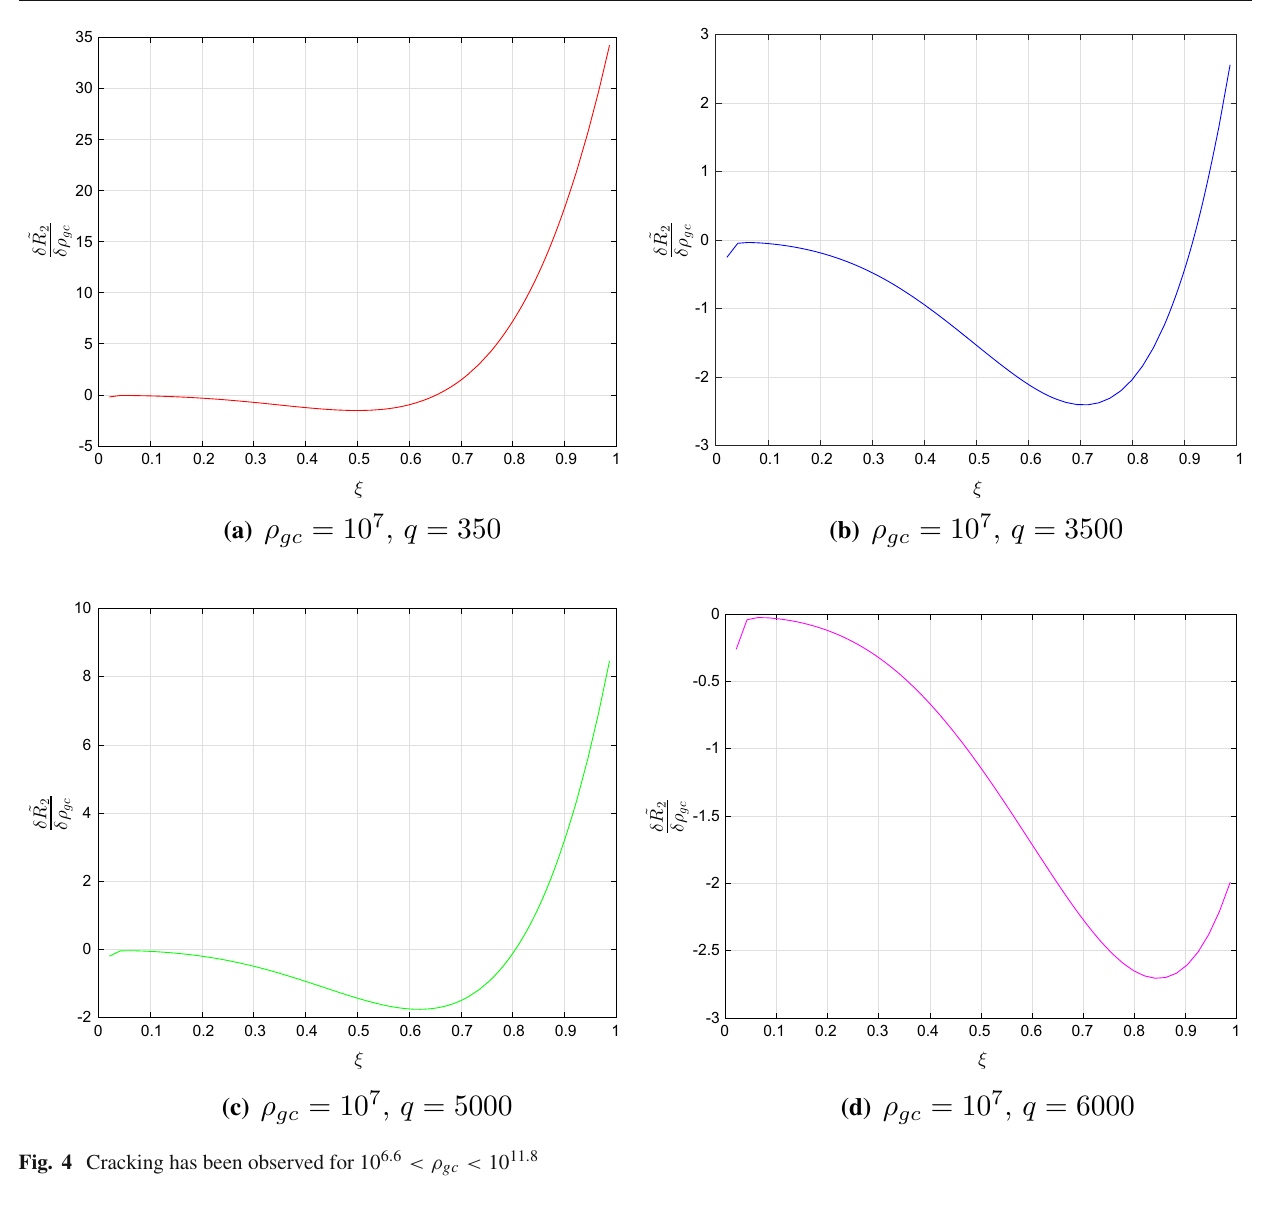
Fig. 4 Cracking has been observed for 10 6 . 6 < ρ gc < 10 11 .